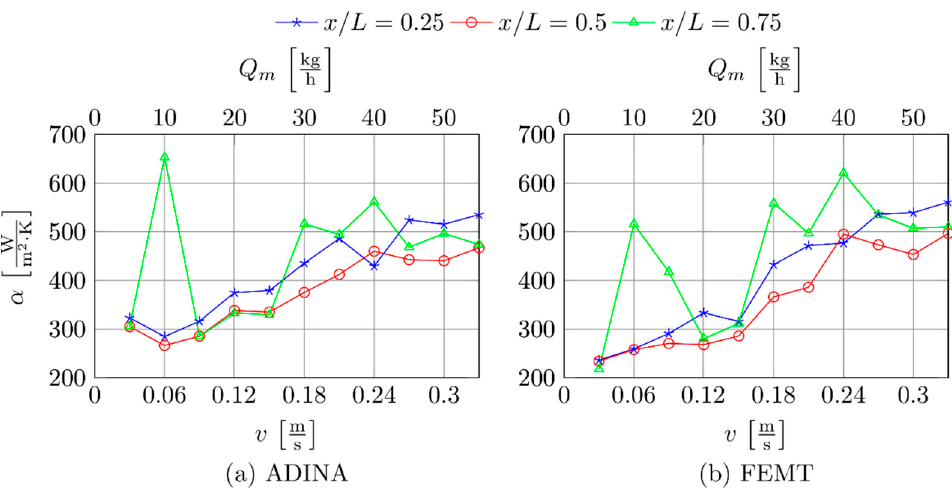
Figure 8. The heat transfer coefficient versus fluid velocity/mass flow rate for three selected distances from the minichannel inlet was defined as x/l , the results obtained from the calculations: ( a ) with the help of ADINA software and ( b ) using Trefftz functions. The data corresponding to ONB points are indicated by black arrows in Figure 4.